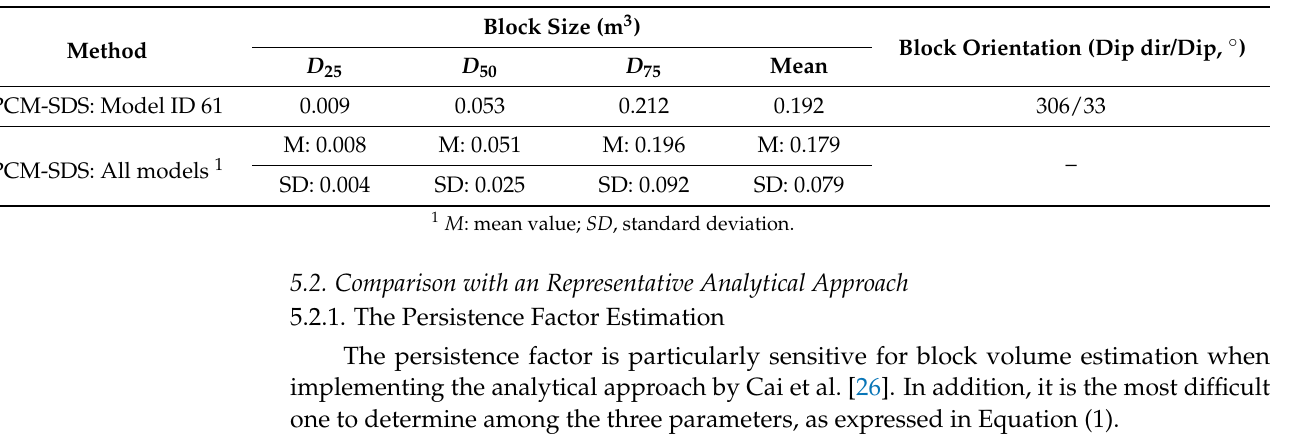
Table 5. Summary of block characterization results of Site 2 acquired from PCM-SDS of the southern